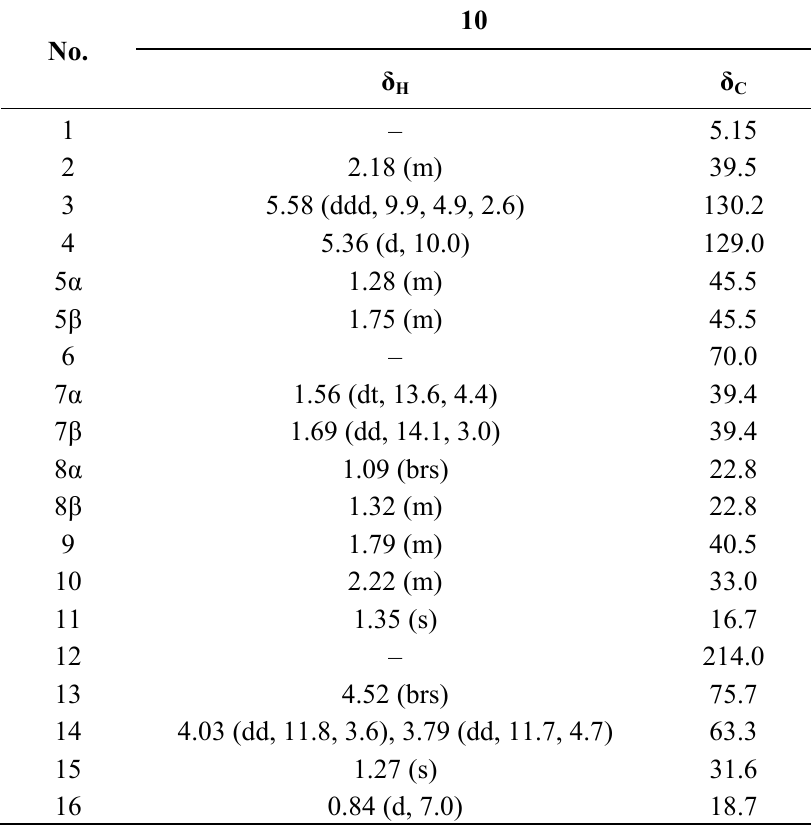
Table 3. 1 H- and 13 C-NMR spectroscopic data of compound 10 (600 MHz, in CDCl chemical shift values are in ppm relative to TMS; multiplicity and J values (in Hz) are presented in